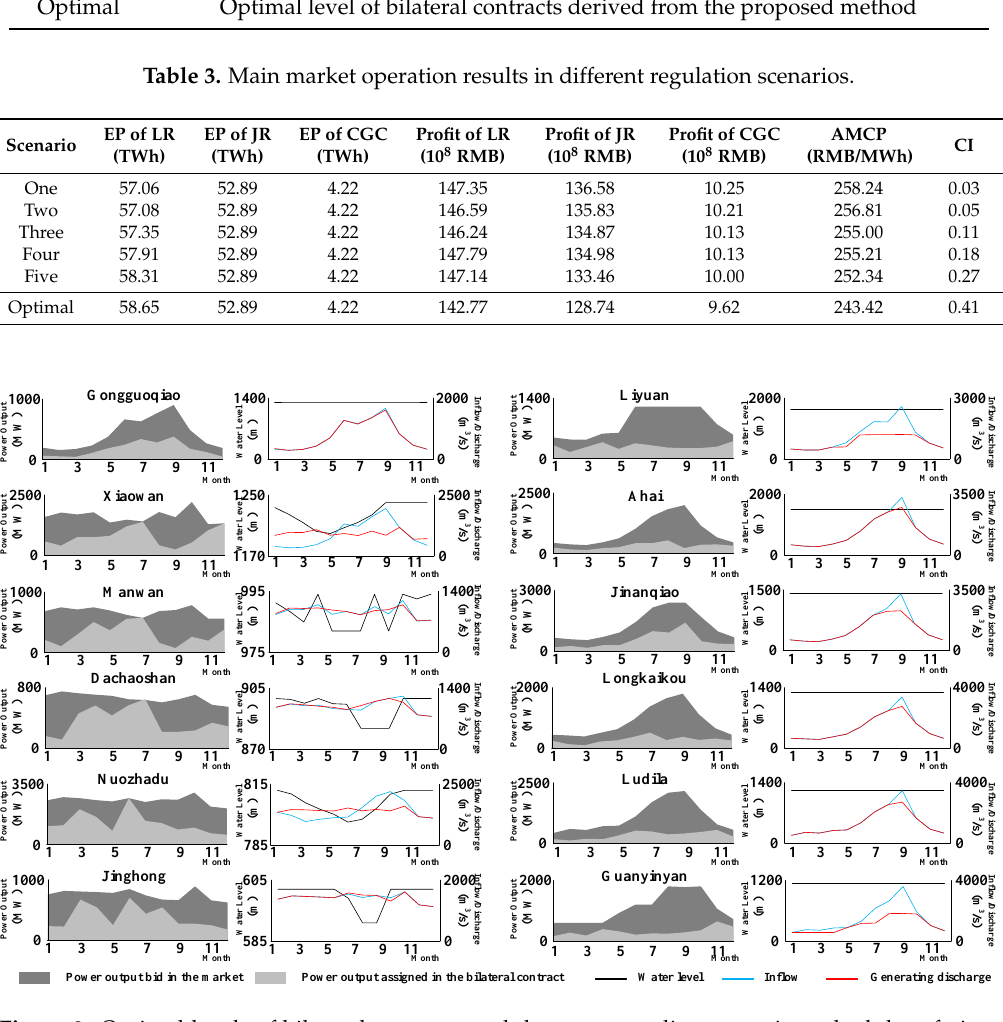
Figure 8. Optimal levels of bilateral contracts and the corresponding operation schedules of giant cascaded hydropower stations.